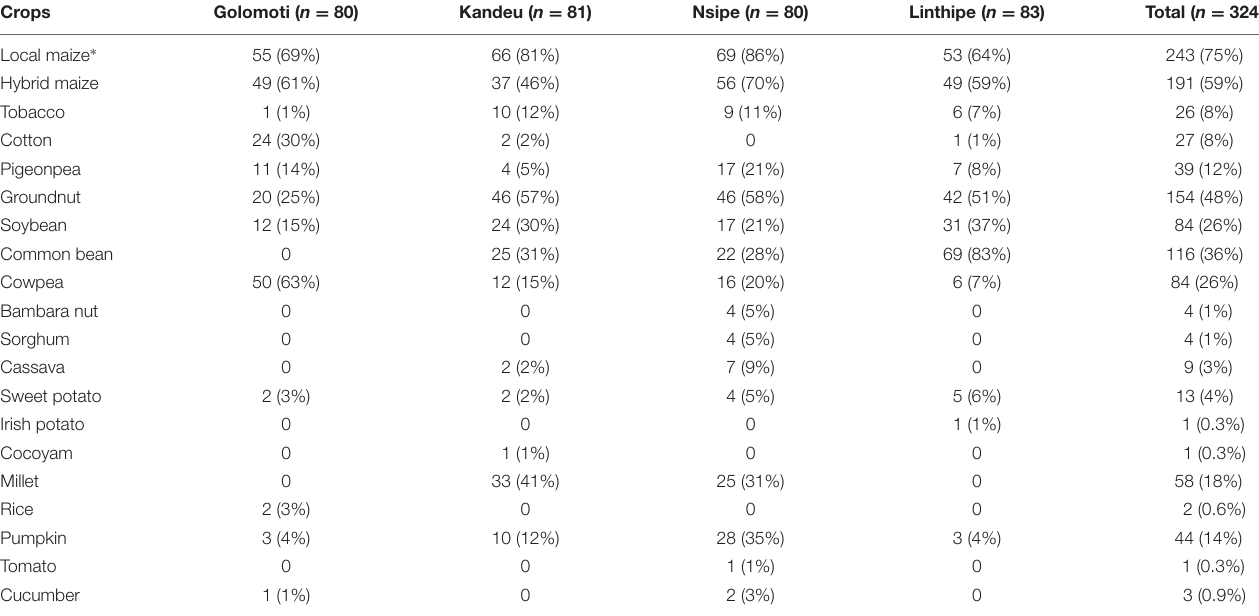
TABLE 4 | Crop species grown in 2012–2013 growing season by farmers at four sites in Central Malawi, number of farmers reporting each crop shown, and percentage of farmers per site presented in parentheses. Crops Golomoti ( n = 80) Kandeu ( n = 81) Nsipe ( n = 80) Linthipe ( n =